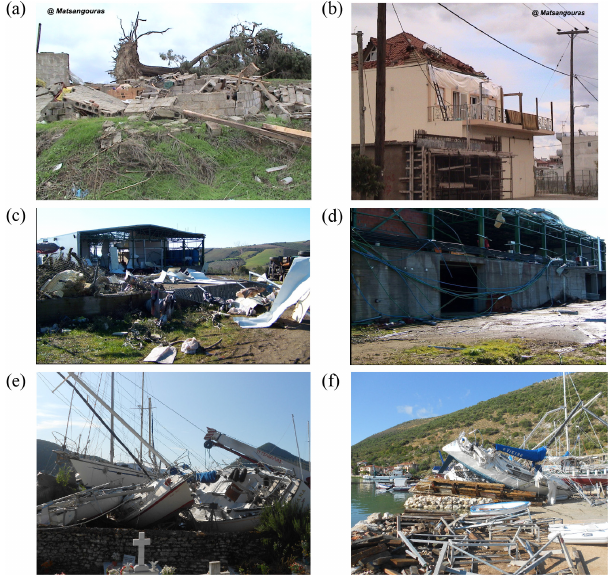
Figure 2. Images (a–h) illustrate the impact of tornadoes to the lo- cal society: (a) and (b) in Thebes, on 17 November 2007 (source: courtesy of 1st author), (c) and (d) in Vrastama, on 12 Febru- ary 2010 (source: http://forum.snowreport.gr/forumposts.asp?TID= _23403{\&}PN=_1), (e) and (f) in Vlychos, on 20 September 2011 (source: http://www.kolivas.de).